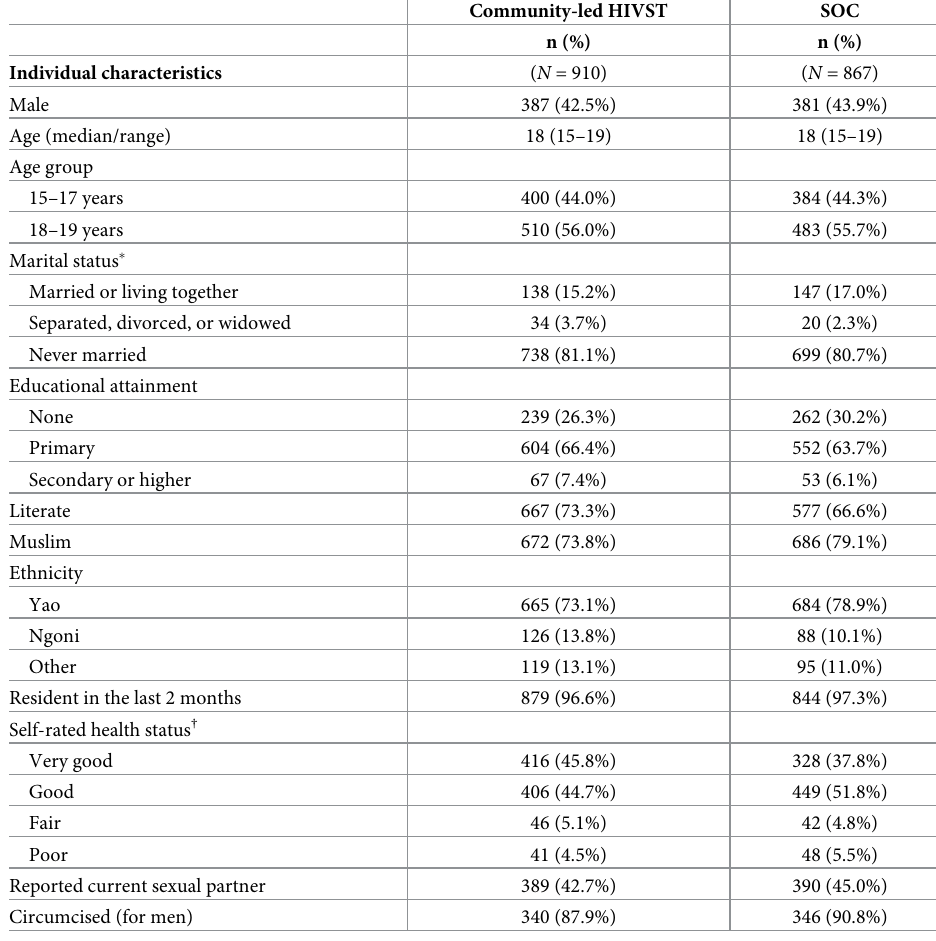
Table 2. Comparison of characteristics for adolescents (15–19 years) by study arm.